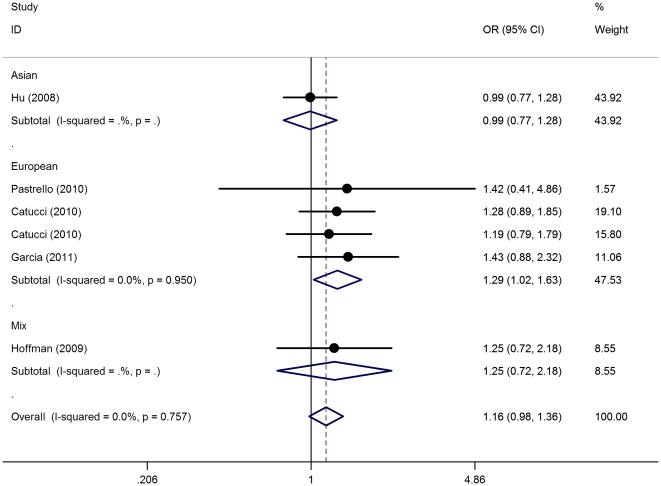
Meta-analysis with a fixed-effects model for the association between breast cancer risk and the has-miR-146a rs2910164 polymorphism(CC vs GG) is illustrated in subgroup analysis by ethnicity.OR: odds ratio; CI: confidence interval; I2, measure to quantify the degree of heterogeneity in meta-analyses.